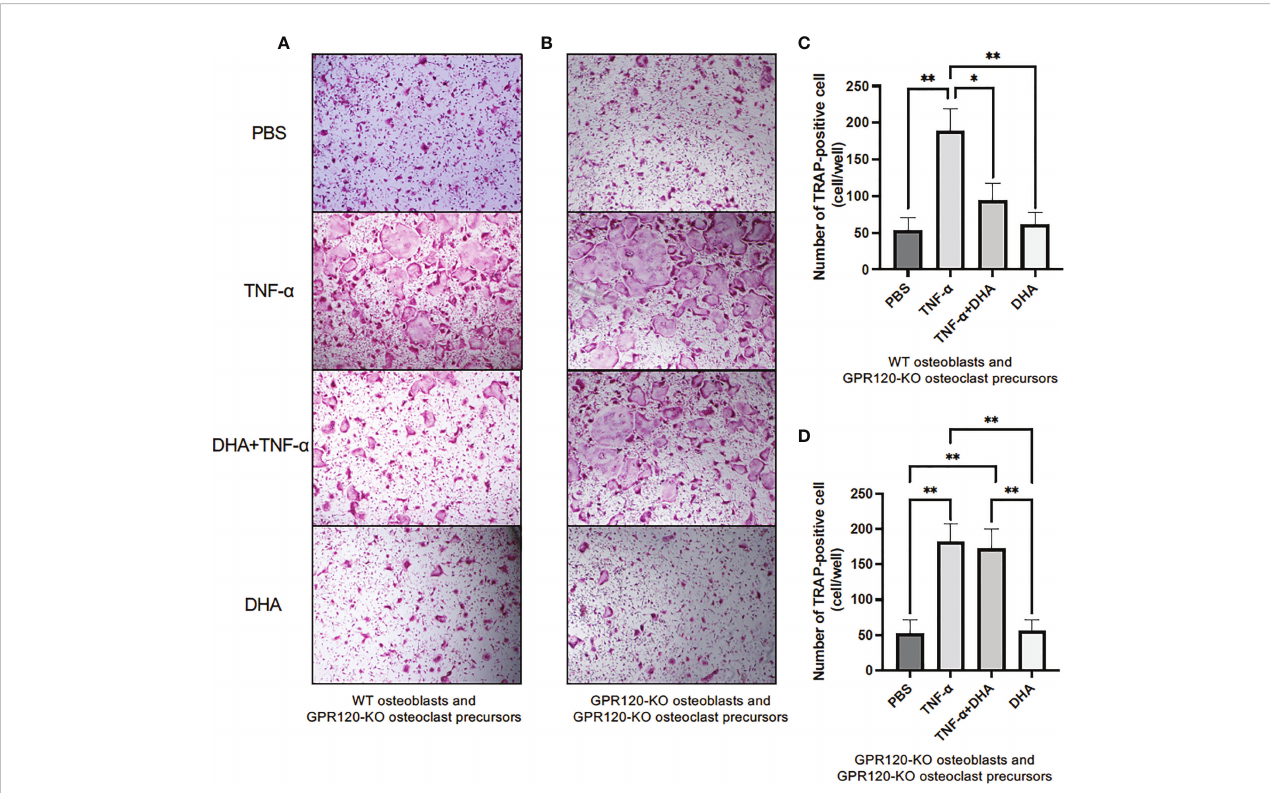
FIGURE 4 DHA inhibited TNF- a -induced osteoclast formation in co-culture using GPR120-KO osteoclast precursors to avoid the effects of DHA on osteoclastogenesis and WT osteoblasts or GPR120-KO osteoblasts. (A) Images of TRAP-positive cells and (C) the numbers of TRAP-positive cells in co- cultures of GPR120-KO osteoclast precursors and WT osteoblasts cultured with PBS, TNF- a (100 ng/mL), TNF- a + DHA, or DHA only in the presence of prostaglandin E2 and 1,25(OH)2D3 for 4 days. (B) Images of TRAP-positive cells and (D) the numbers of TRAP-positive cells in co-cultures of GPR120-KO osteoclast precursors with GPR120-KO osteoblasts cultured with PBS, TNF- a (100 ng/ml), TNF- a + DHA, or DHA only in the presence of prostaglandin E2 and 1,25(OH)2D3 for 4 days. The results are given as means ± SD. Scheffe ́ ’ s test was used to determine the statistical signi fi cance of differences (n = 4; * p < 0.05, ** p <